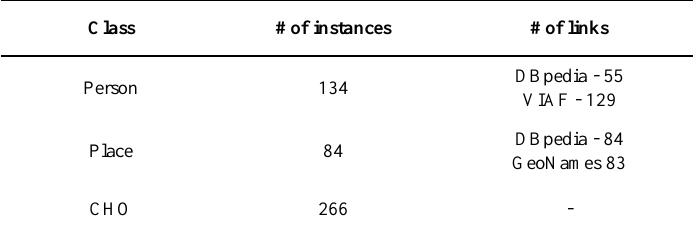
Table 1. Statistics about the knowledge base related to the Clavius’s